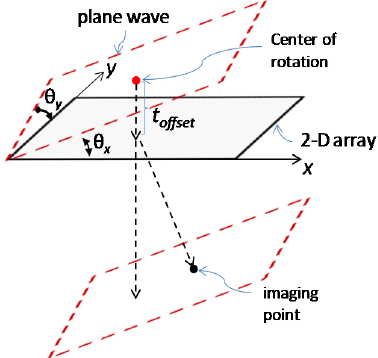
Figure 3. Geometrical description of coherent angular compounding.